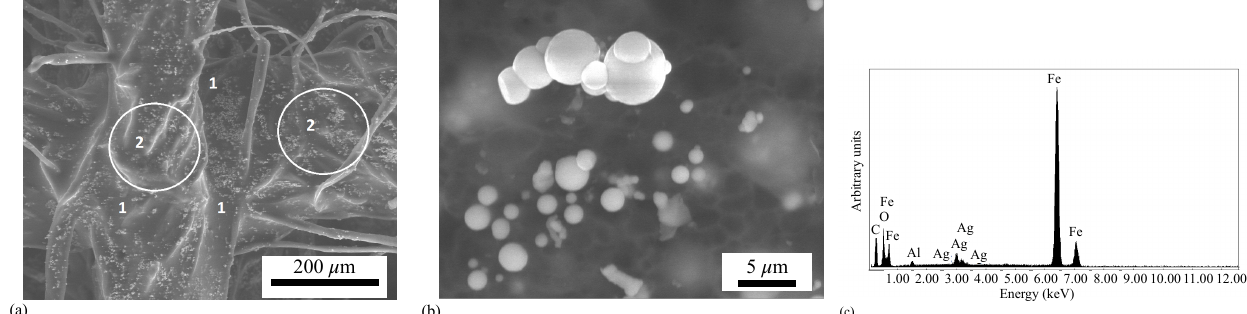
Figure 4. SEM and EDX data of the membrane with honey, CI, and silver nanoparticles (M 6 ). ( a ) 1—Cotton microfibers, 2—Honey with CI and silver microparticles. ( b ) Largest spheres—CI microparticles; smaller spheres—silver microparticles. ( c ) Elemental